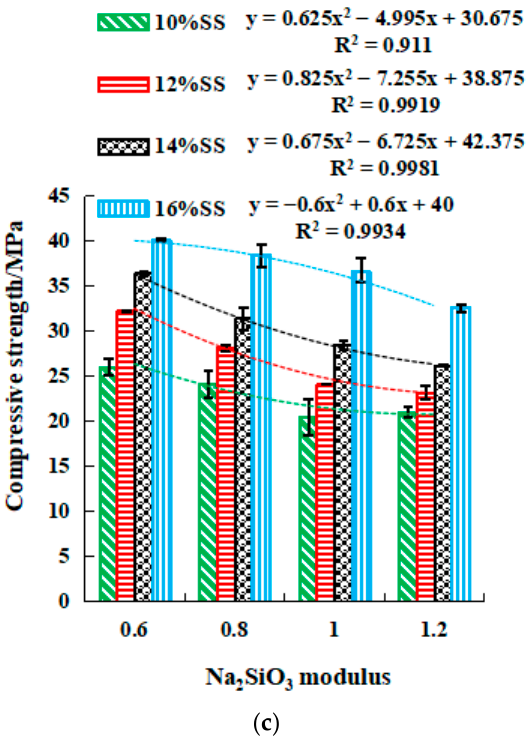
Figure 8. The relationship between modulus and compressive strength. ( a ) 3 days, ( b ) 7 days, ( c ) 28 days.